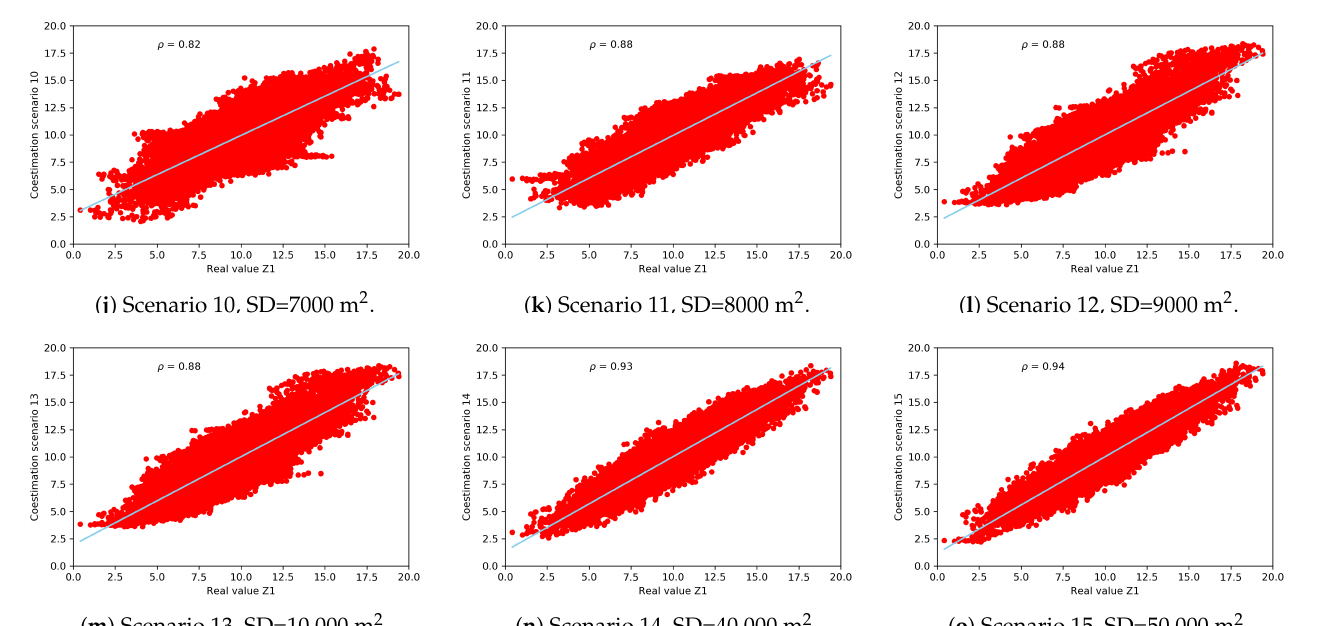
Figure 8. Dispersion diagrams between the real variable Z 1 and the 15